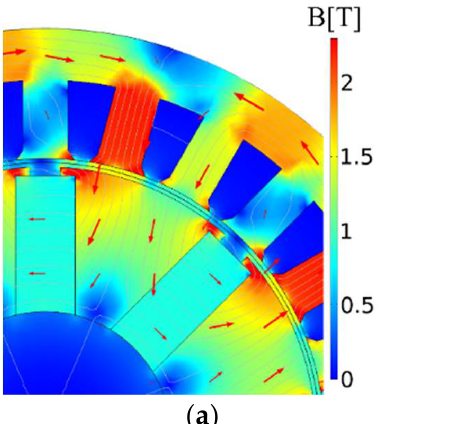
Figure 20. Losses computed using 2D time-dependent FE simulation (2D-time) and the 2D station-